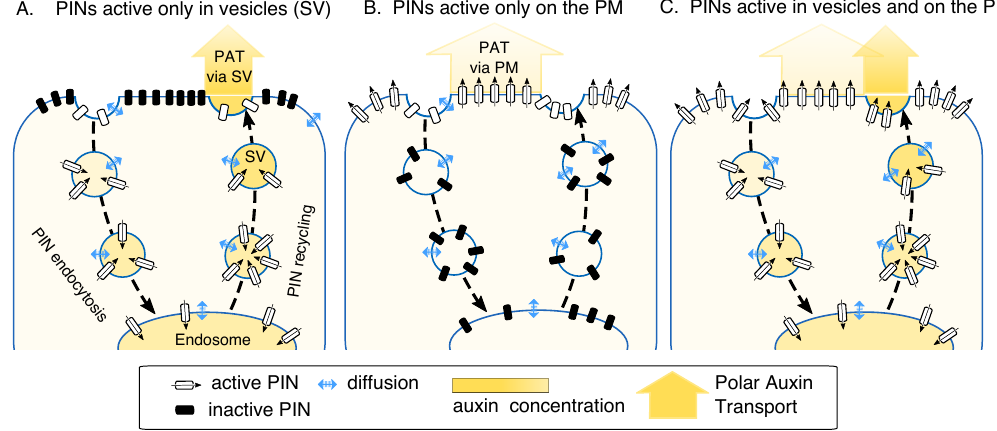
Figure 1. ( A – C ) Schematics of PIN-formed (PIN) endomembrane trafficking and possible auxin transport